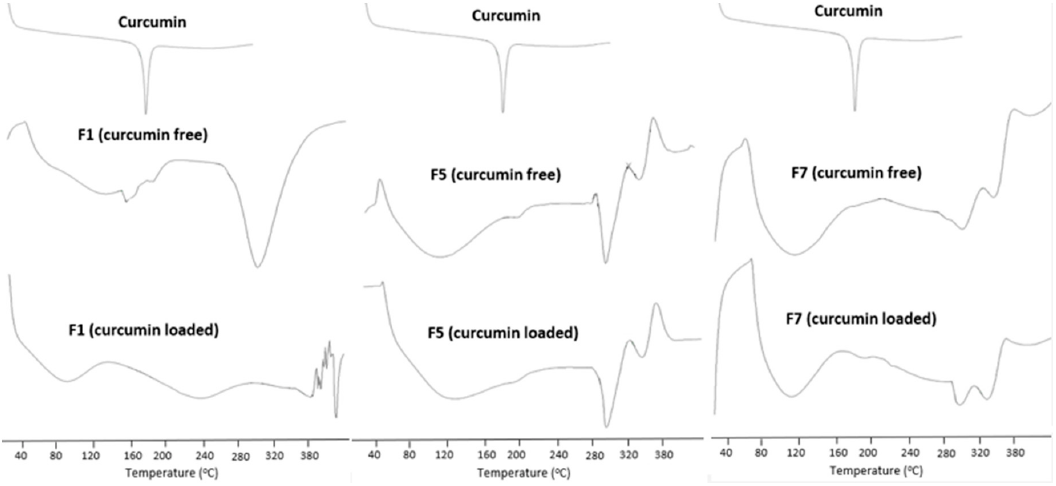
Figure 3. DSC thermograms of three representative curcumin inserts (F1, F5 and F7).